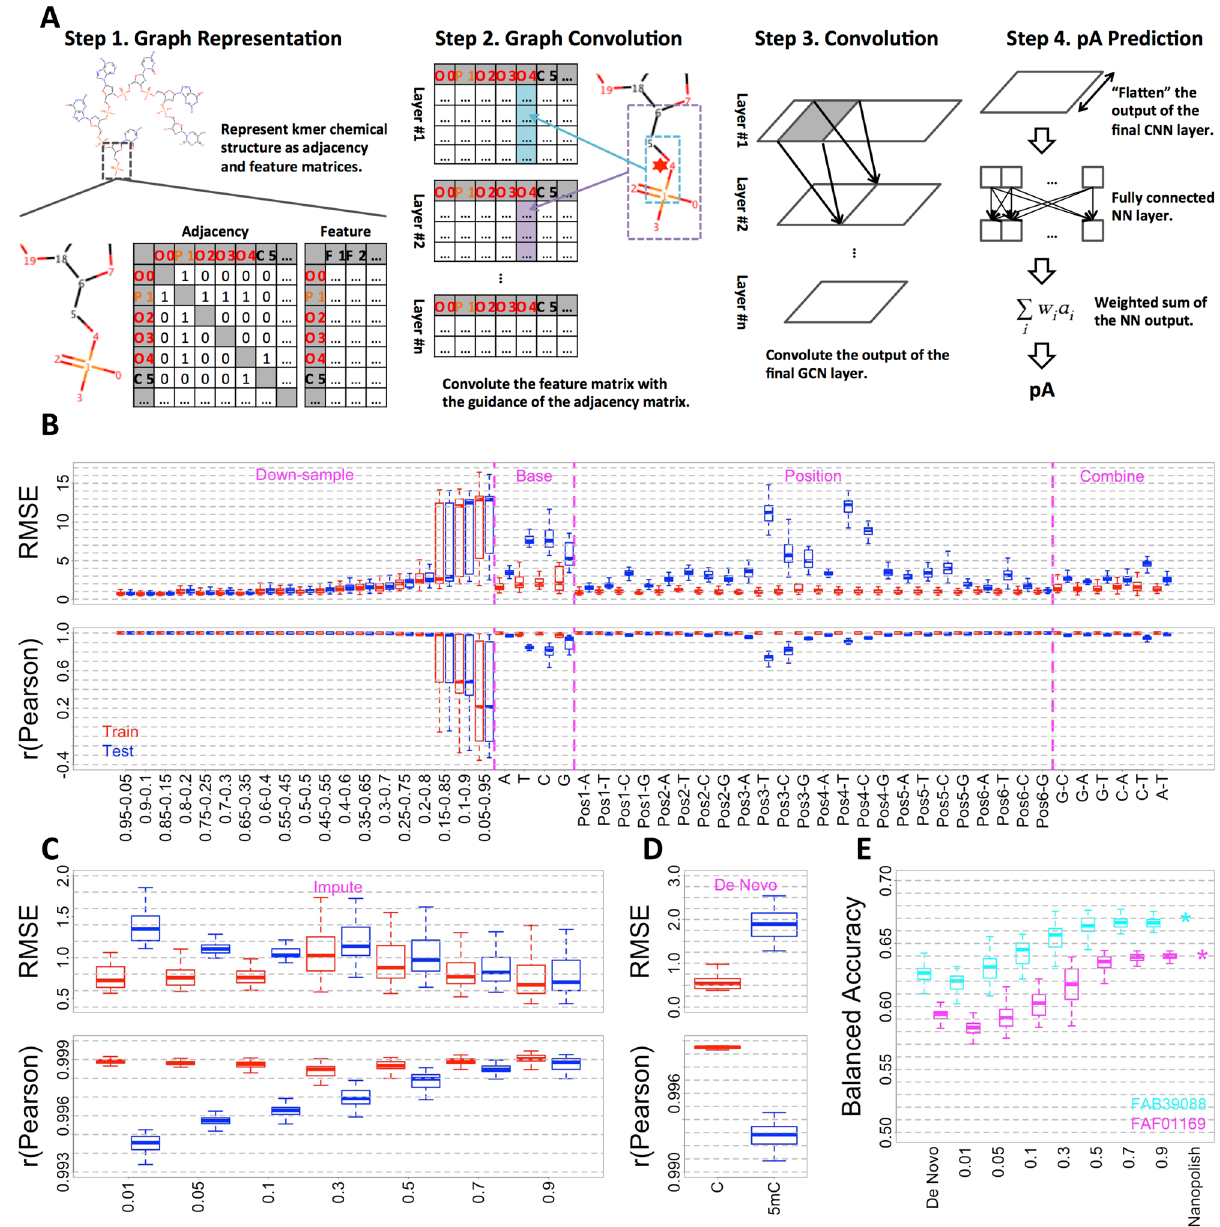
Fig. 1 Predicting kmer characteristic ionic currents from chemical structures. A Graphic overview of the proposed deep learning framework for DNA analysis. B Goodness of fi t of DNA canonical random downsample, base-dropout, position-dropout, and model combination analyses. Speci fi cally, “ downsample ” denotes the random dropout experiment, where we create random train-test splits. “ Base ” denotes base-dropout experiment, where we drop DNA 6mers that contain a speci fi c base in any given position during training. “ Position ” denotes positional base-dropout experiment, where we drop DNA 6mers that contain a speci fi c base in a given position during training. As for “ combine, ” we drop DNA 6mers that contain both of the speci fi ed bases during training. C Goodness of fi t of 5mC-containing DNA 6mer imputation analysis. D Goodness of fi t of de novo 5mC-containing DNA 6mer prediction. C and 5mC refer to the goodness of fi t of canonical DNA 6mers and 5mC-containing DNA 6mers, respectively. In B – D , Train (red) and Test (blue) refer to the goodness of fi t of the training and test DNA 6mers, respectively. E Predictive accuracy of C/5mC status quanti fi ed by balanced accuracy. Nanopolish, predictive analysis with the nanopolish model as baseline control. De Novo, predictive analysis with 5mC-containing DNA 6mer models described in ( D ), which were predicted from canonical training. 0.01 – 0.9, predictive analysis with different imputation 5mC-containing DNA 6mer models as described in ( C ). FAB39088 (cyan) and FAF01164 (purple) refer to two independent NA12878 cell line native genomic DNA nanopore sequencing datasets. Throughout ( B – E ), the median, minimum/maximum (excluding outliers), and fi rst/third quartile values were shown by the